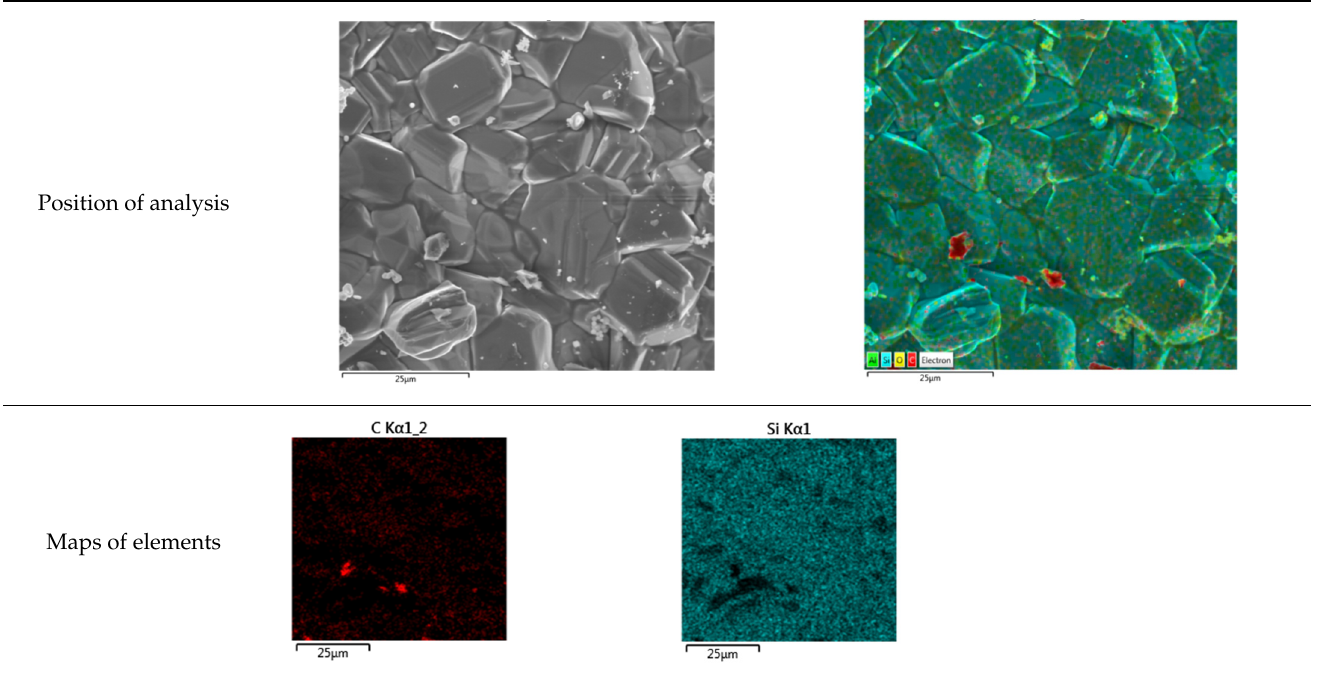
Table 7. Microscopic analysis of product (Silicon Carbide–SiC) after carbothermic reduction of quartzite Ukraine at 1800 °C.